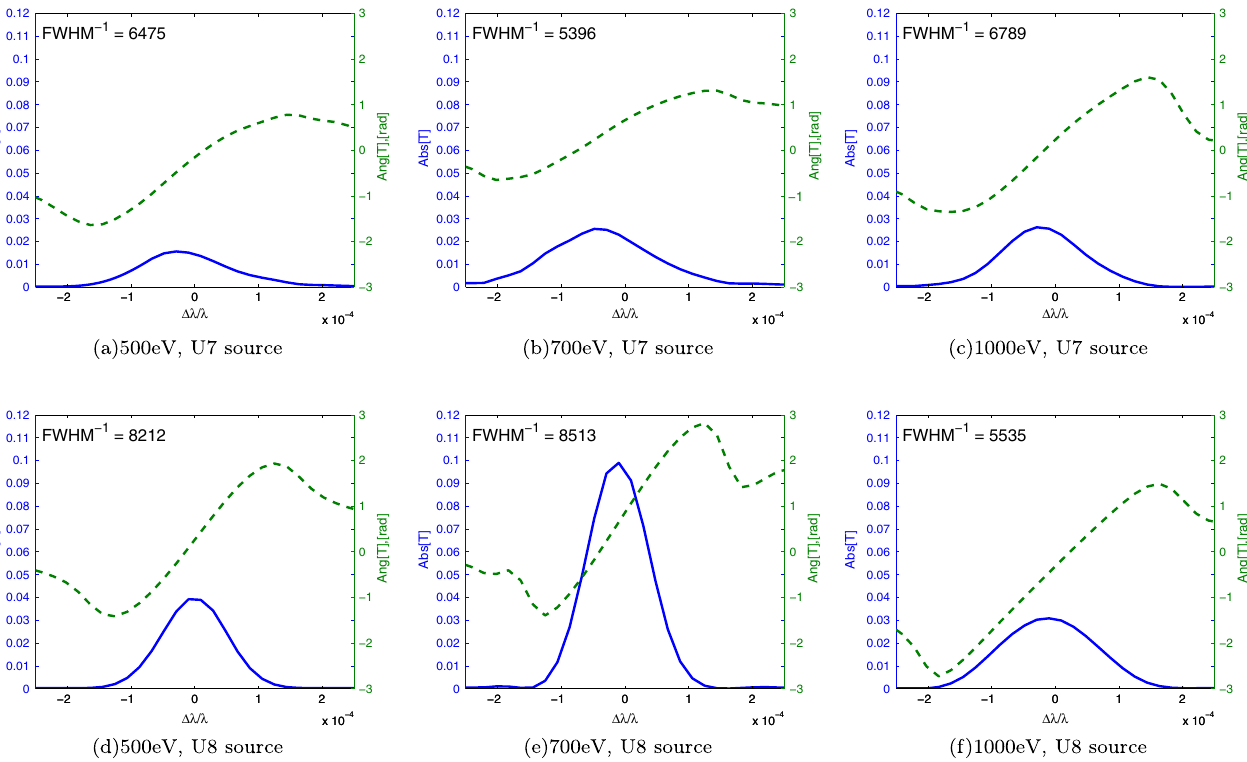
FIG. 15. Monochromator instrumental functions for different photon energies and source positions (undulator U8 “ in, ” leading to source position in this undulator, or undulator U8 “ out, ” resulting in the source within undulator U7). “ Abs ” stands for absolute value of an instrumental function, while “ Ang ” is a corresponding phase. Physical slit in this case is not inserted. Inverse Full width at half maximum can be interpreted as an effective resolving power of the